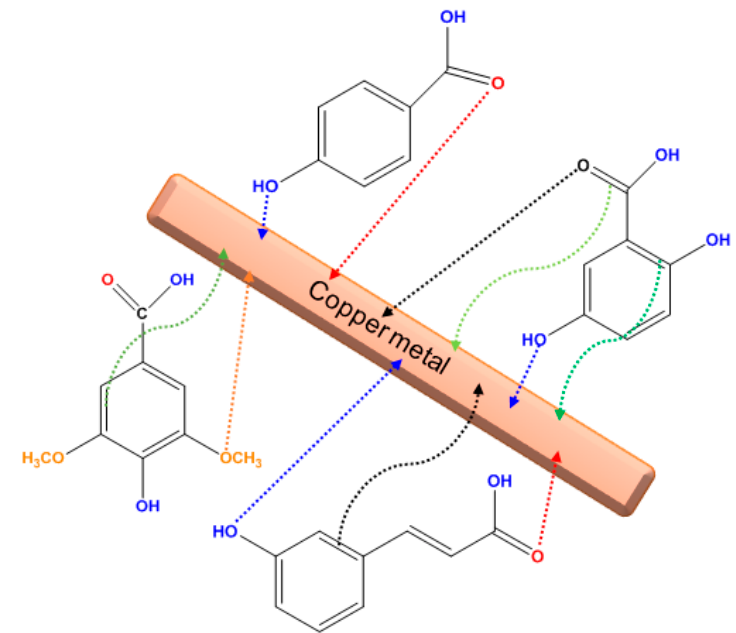
Figure 7. Mechanism of corrosion